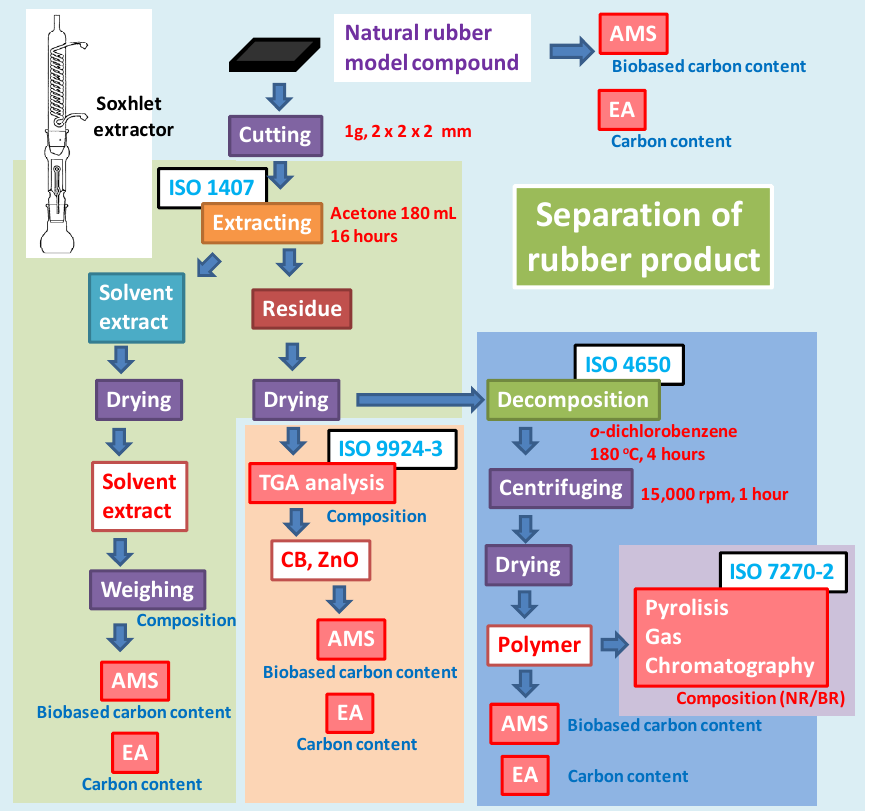
Figure 4. Separation methods based on ISOs for natural rubber model compound. carbon black (CB); zinc oxide (ZnO); elemental analysis (EA); accelerator mass spectroscopy